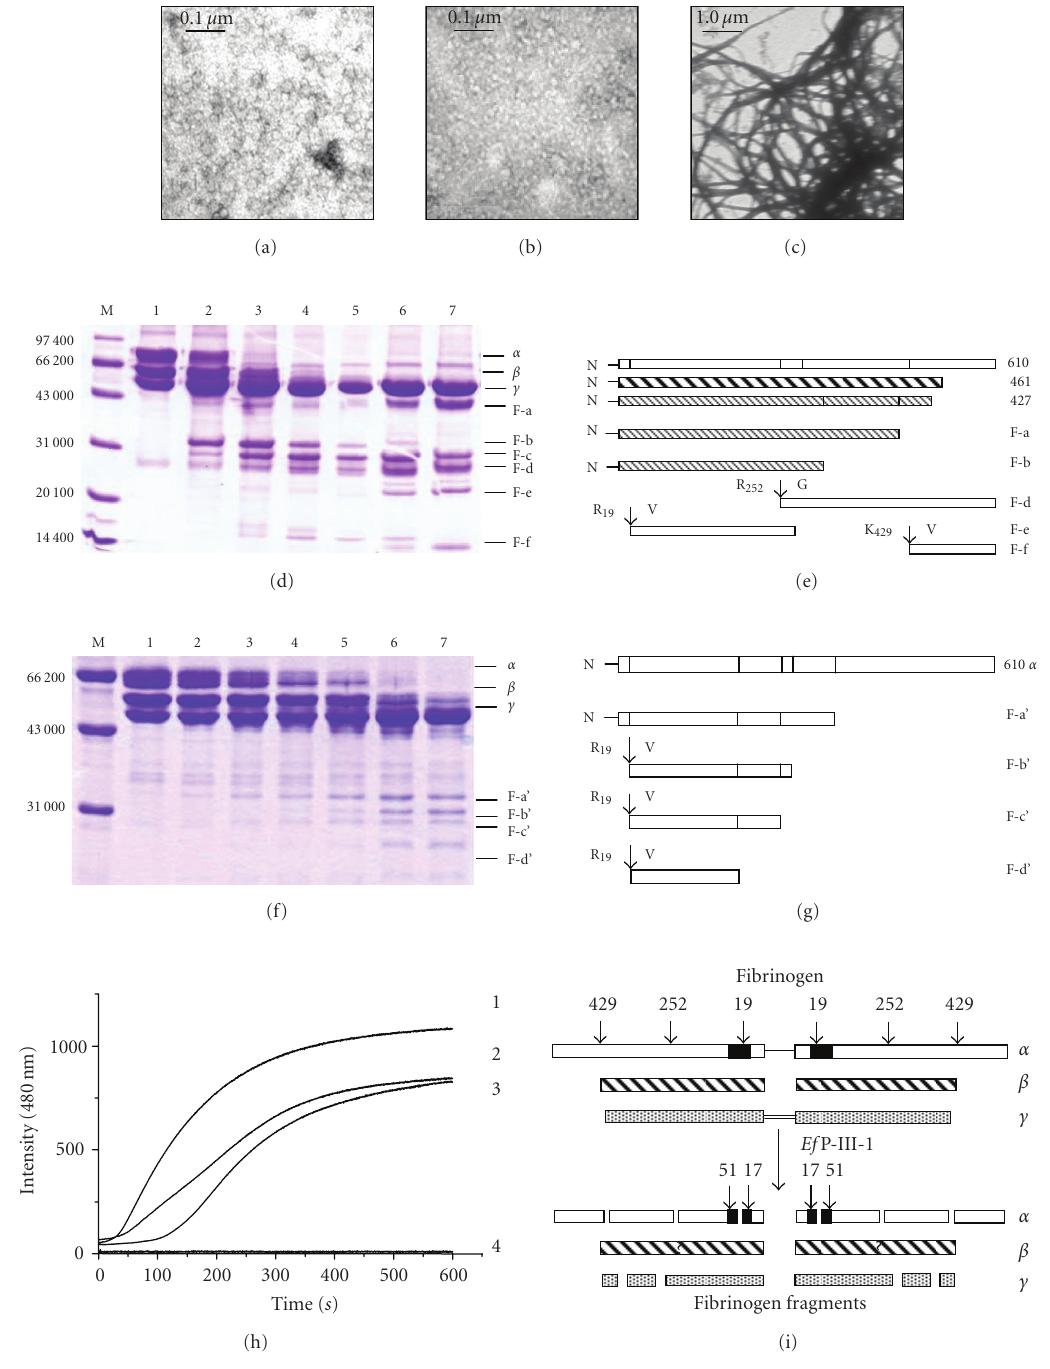
Figure 2: Hydrolysis of fibrinogen by Ef P-III-1. Ef P-III-1 (0.1 μ M final concentration) was incubated with human fibrinogen (2mg/mL in 50mM Tris-HCl bu ff er, pH 7.4) at 25 ◦ C. (a–c) Fibrinolysis in the presence of Ef P-III-1 (a) was detected by electron microscopy. Ef P-III-1 (b) and fibrin alone (c) were used as controls. (d,e) 12% SDS-PAGE showing fibrinolysis in the presence of Ef P-III-1 (d). M: low-molecular- mass protein markers; lane 1: fibrinogen which consists of three polypeptide chains: α (66kd), β (54kd), and γ chain (48kd) as control; lanes 2 through 7: aliquots were taken at 0, 5, 15, 30, 60, and 120 minutes during the hydrolysis. (e) The fibrinolytic fragments (F-a to F-f) in the presence of Ef P-III-1 (e). (f,g) fibrinolysis in the presence of immobilized Ef P-III-1 under the same conditions. α -Fibrinogen fragments were indicated by F-a’ to F-d’ (g). Fibrinolytic activity (2.5mg/mL, 10 minutes, 25 ◦ C) was measured by light scattering assay (h). Thrombin was added to fibrinogen in the absence of Ef P-III-1 as a control (curve 1); both Ef P-III-1 and thrombin were added to fibrinogen at the same time (curve 2); Ef P-III-1 was incubated with fibrinogen at 25 ◦ C for 10 minutes before thrombin was added (curve 3), and Tris-HCl bu ff er as a negative control (curve 4). Ef P-III-1 cuts at R 19 -V 20 and destroys the N-terminal 35-residue stretch (black) which is the key recognition motif for thrombin (i), according to C. Fuss et al.